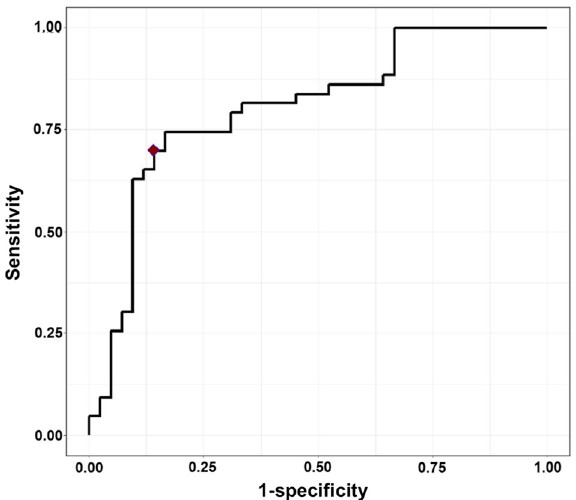
Figure 4. The ROC curve for classification of supernatant urine samples using multivariate logistics regression (MLR) model with marker SEPT9 and interaction of markers SEPT9 and SDC2 . The red diamond indicates the maximal Youden’s index.